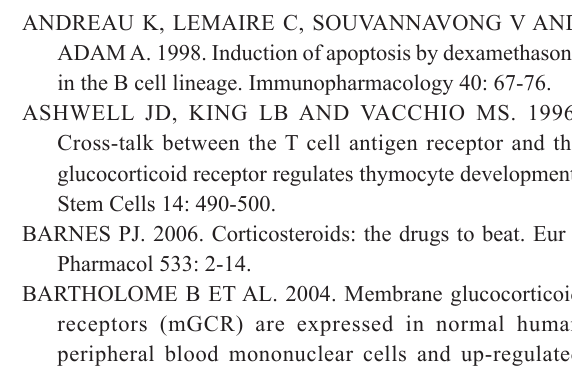
Symbols in table are representative of transport reversal index (Δ). (Ø), no ABCB1 activity; (+), Δ < 2.0; (++) 2.0 ≤ Δ < 4.0; (+++) and (+++) Δ ≤ 4.0. In mice treat with hydrocortisone (70 or 140 mg/kg/day), (=) represents no change in ABCB1 activity and (↑), increase in activity in vivo , according to the statistical